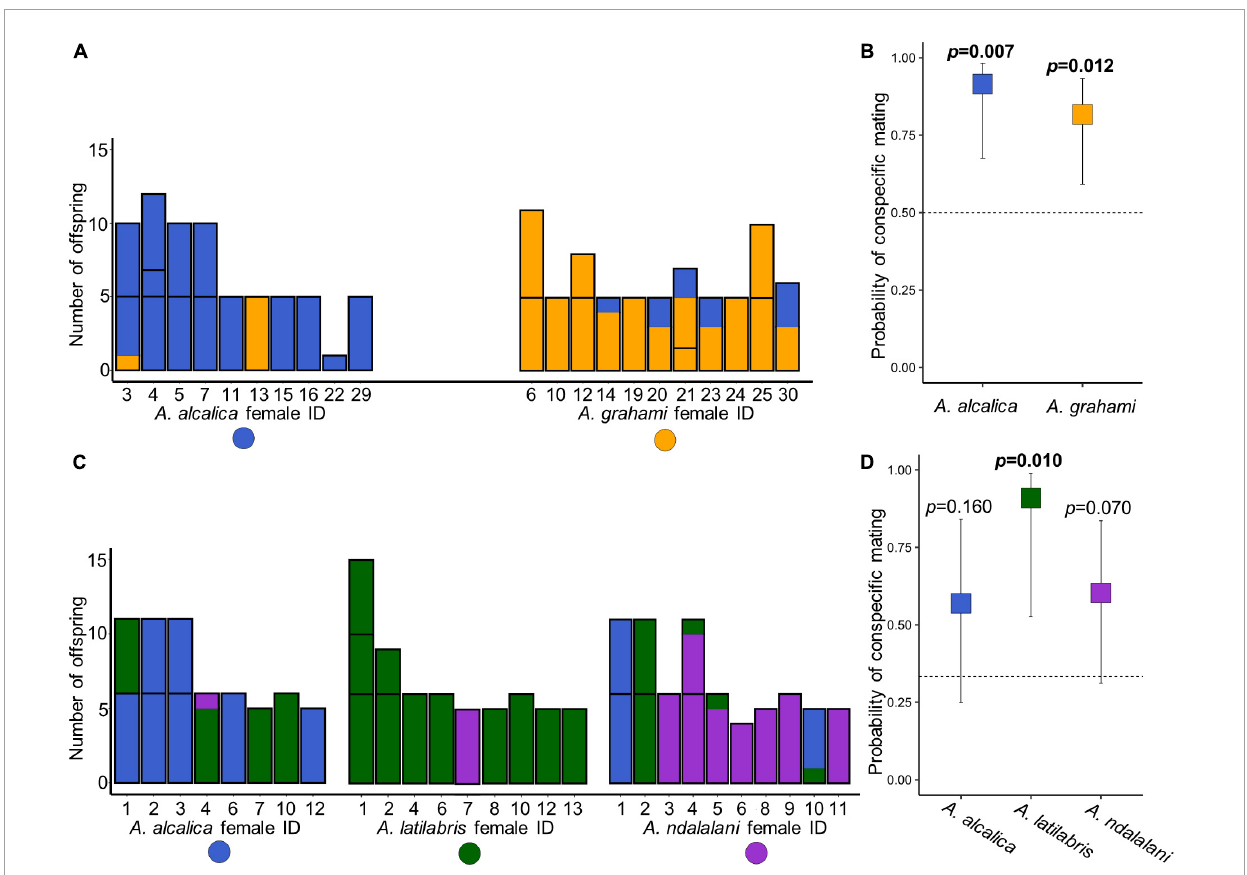
FIGURE3 Assortative mate choice in Alcolapia from offspring paternity data. Barplots show paternity of offspring for each spawning female in both allopatric (A) and sympatric (C) experiments. Colors denote the paternal species assigned from the microsatellite data: orange = A. grahami , blue = A. alcalica , green = A. latilabris , purple = A. ndalalani . Each column represents an individual female. Within columns, individual clutches are separated by black bars. (B,D) Boxplots showing the predicted probability of females mating with conspecific species estimated from offspring paternity data, (B) allopatric experiment, (D) sympatric experiment calculated from the model outputs of the GLMs. Error bars denote 95% Wald confidence intervals for the estimates. Dotted lines show the mean expected probability of mating with conspecifics given random mating. In both experiments, mating was assortative overall ( p = 0.001). However, in the sympatric experiment, tests for assortative mating were not significant for A. alcalica (p = 0.16) and A. ndalalani ( p =